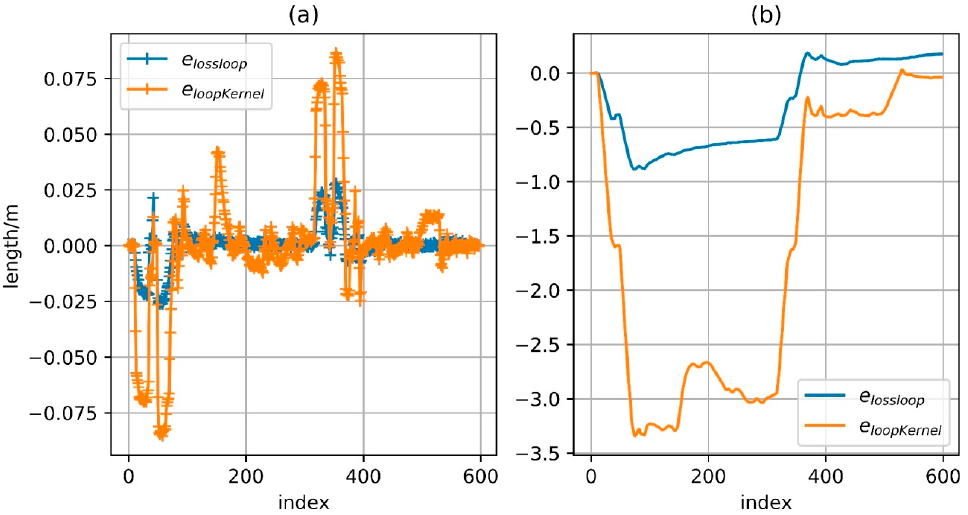
Figure 20. Comparison of step size variation and cumulative variation. ( a ) Difference of the step size between the optimization result and zupt-processed result; ( b ) Cumulative value of step size variation of the optimization result.